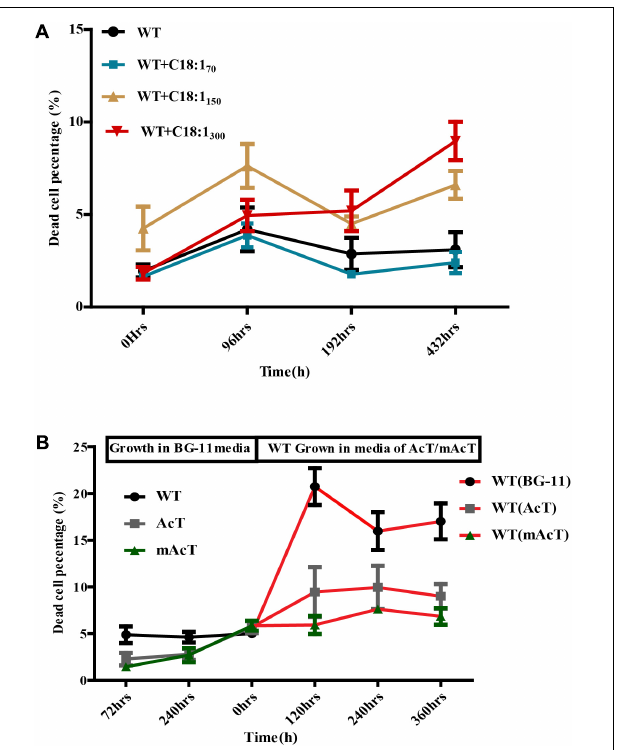
FIGURE 6 | Effect of exogenously added C18:1 FFA and extracted media of mutant strain on WT cells. (A) Effects of exogenously added C18:1 fatty acid on the cell survivability of FFA-producing strain. Cells were grown either with or without C18:1 unsaturated fatty acid with different concentrations (70 mg · L − 1 to 300 mg · L − 1 ) in medium, and the damaged cell percentage was determined by FACS at different time points. (B) Role of membrane scaffold on cell survivability. The WT cells were grown in the absence (WT without MS media) or presence (WT in mAcT/AcT media) of media from mAcT/AcT strains (MS media) after 10 days of normal growth in BG-11 media. Data shown here are the mean ± SE from biological